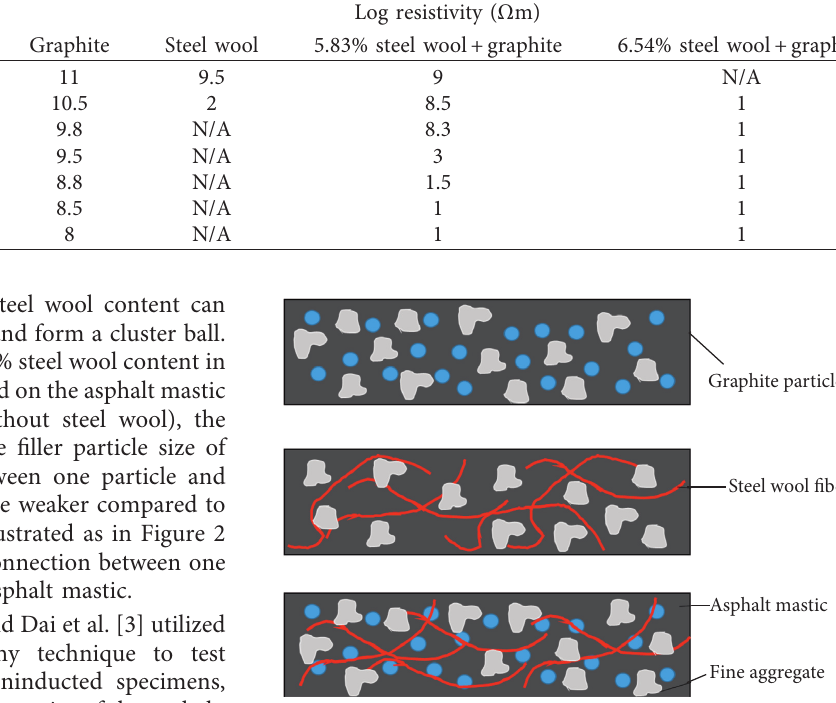
Figure 2: Illustration of asphalt mastic composition with and without steel wool and